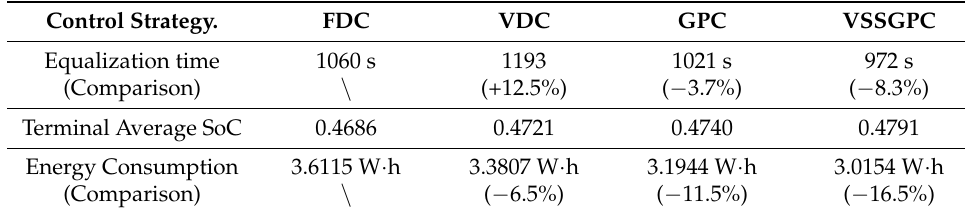
Table 6. Equalization experiment result.